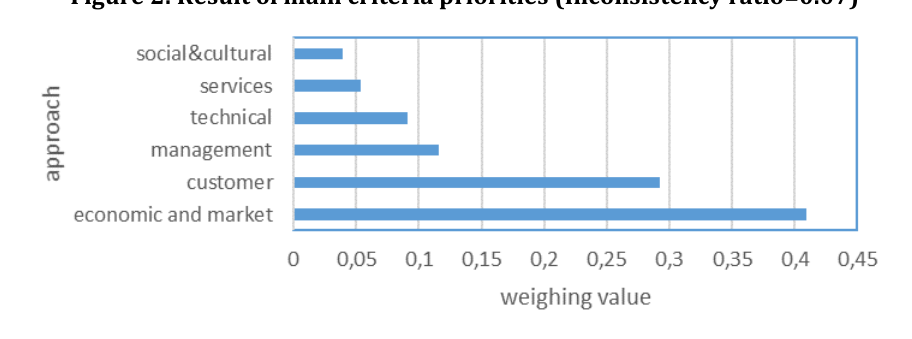
Figure 2: Result of main criteria priorities (Inconsistency